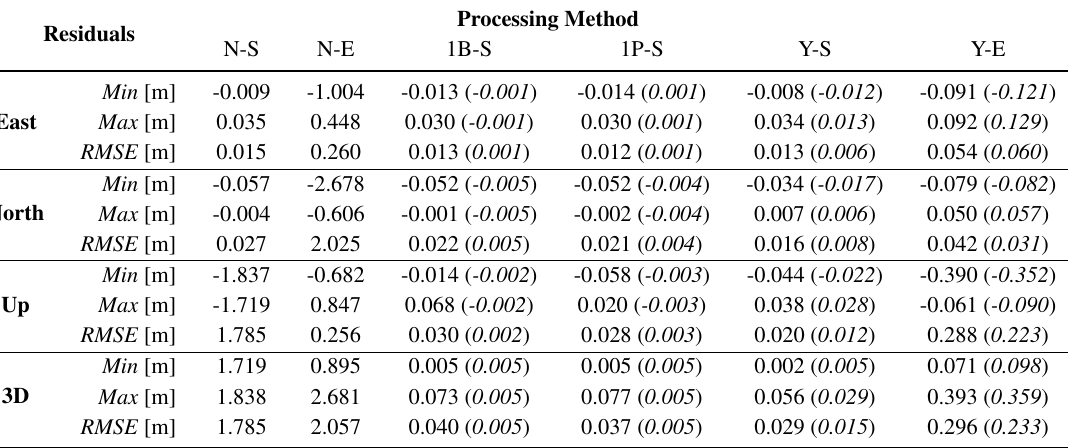
Table 4. Summary of the residuals for oblique imageries with RTK camera coordinates and Exif recorded ENU standard deviations. Abbreviations are explained in (1) and